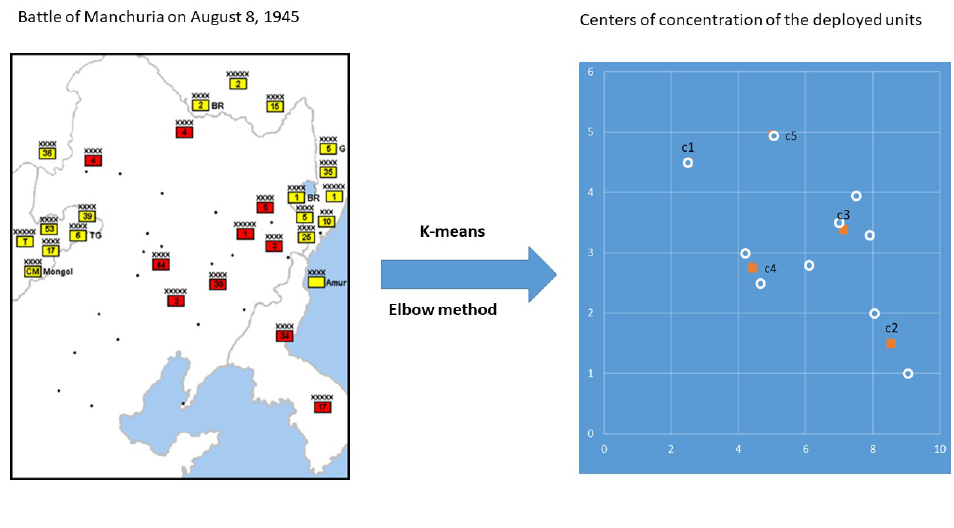
Figure 5. The figure on the left depicts the situation described in the biography of the battle of Glantz [27] between Japanese (red) and Russian (yellow) forces. The right-hand figure shows the COGs obtained by applying K-Means plus Elbow